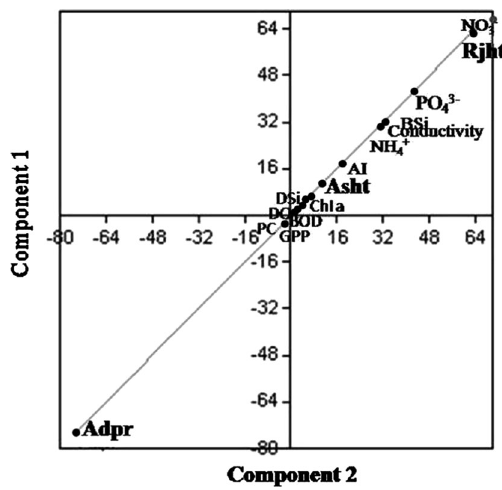
Fig. 6 Principal component analysis (PCA), based on water quality data and pollution input, separates sampling locations and other vari- ables at different ordinates. Rjht, the most polluted site, is separated with NO 3− , PO 43− , NH 4+ and conductivity, while Adpr, the least pol- luted site, is separated opposite to Rjht